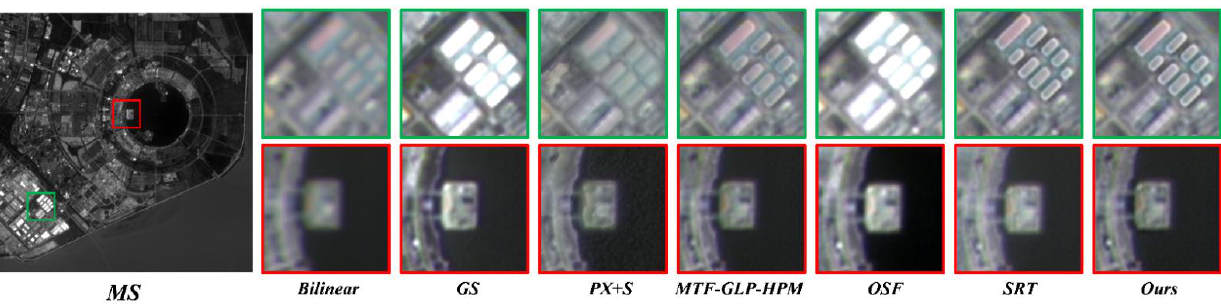
Figure 10. The results of different fusion methods are shown for the Dripping Lake area in Shanghai.